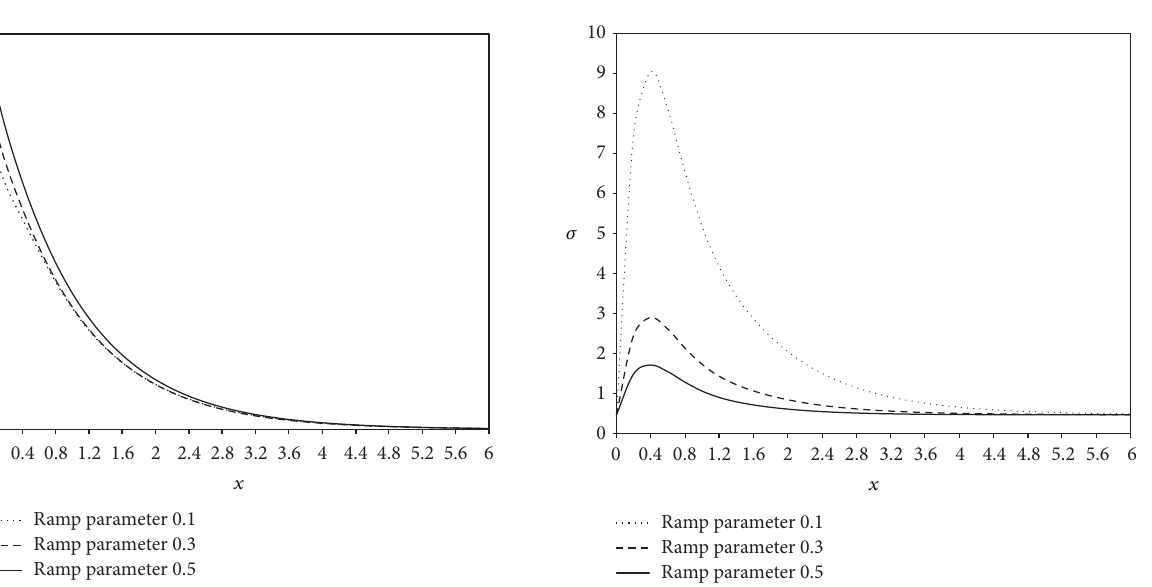
Figure 7: Displacement distribution 𝑢 for different values of ramp parameter at 𝛼 = 0.5 , 𝑡 = 0.1 .